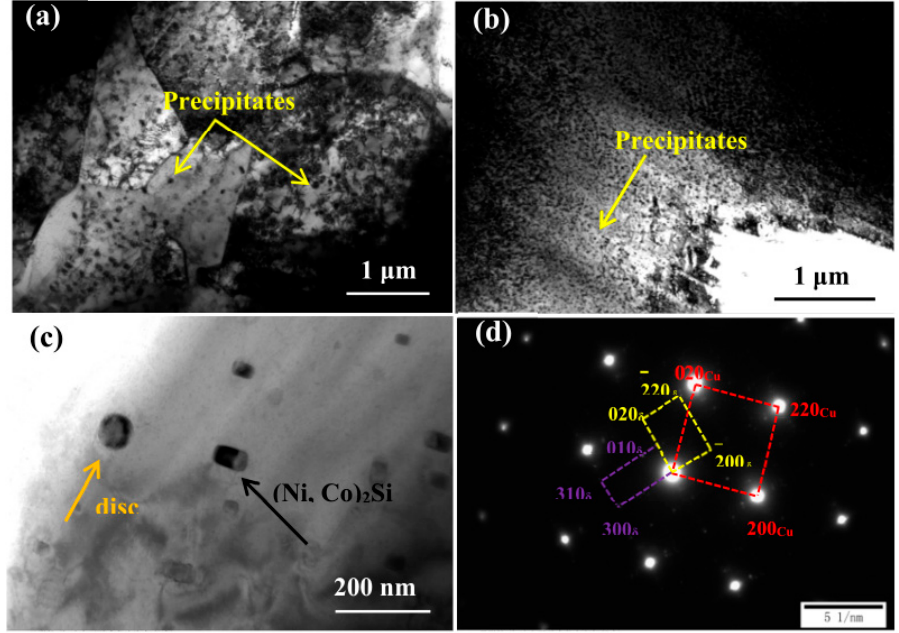
Figure 6. TEM images of samples deformed at 700 °C and 0.01 s − 1 : ( a ) Cu–Ni–Co–Si–Cr; ( b , c ) Cu– Ni–Co–Si–Cr–Ce; ( d ) SADP of corresponding area in ( c ) [13]. Reprinted/adapted with permission from Ref. [13]. Copyright year 2020, MDPI AG.